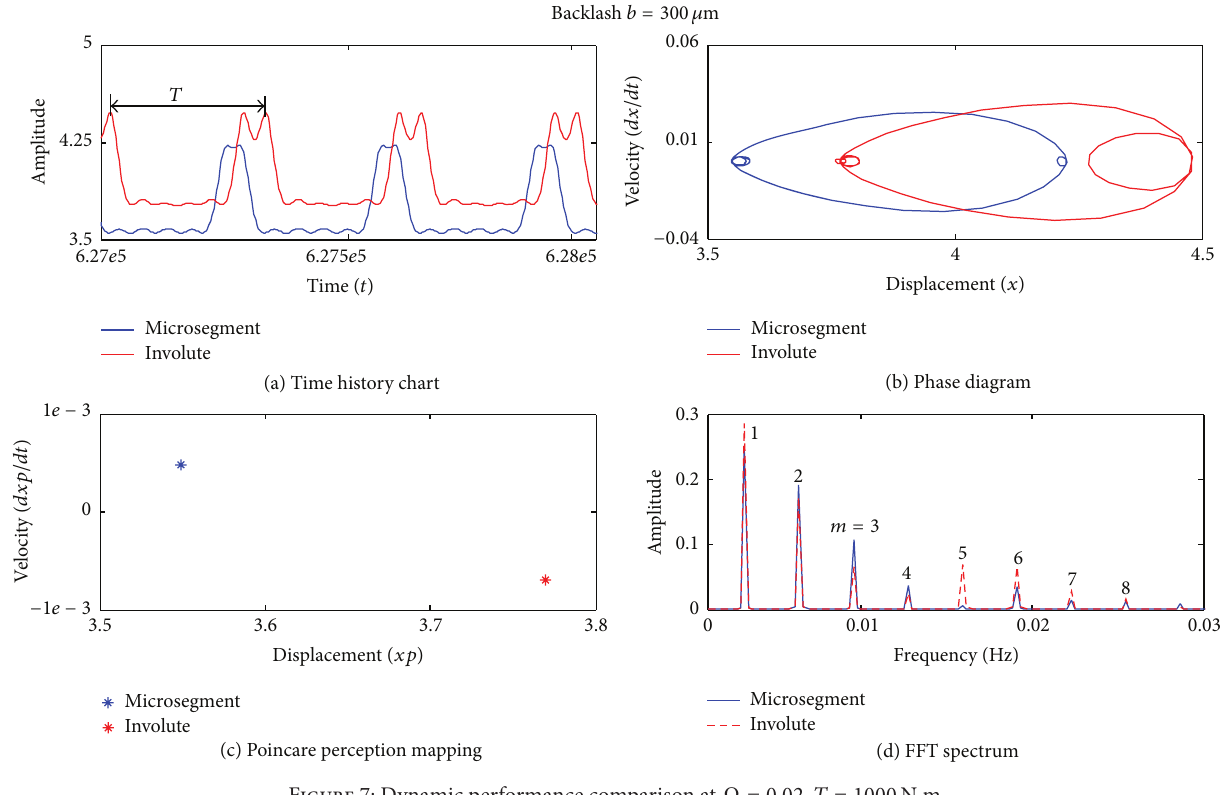
Figure 7: Dynamic performance comparison at Ω = 0.02 , 𝑇 = 1000 N ⋅